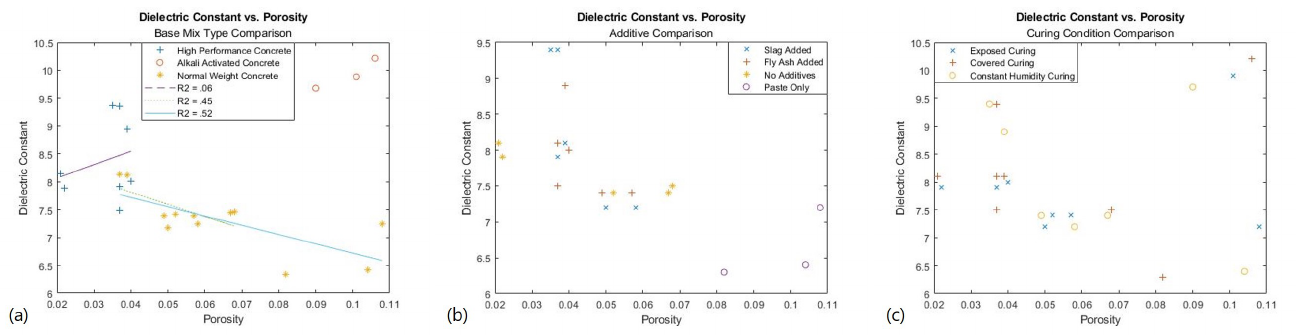
Figure 9. Dielectric constant vs. porosity with breakdowns of base mix ( a ), additives ( b ), and curing condition ( c